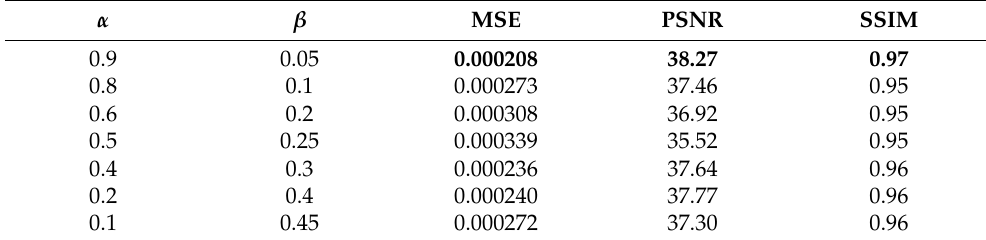
Table 9. Quantitative comparison of different weights for loss